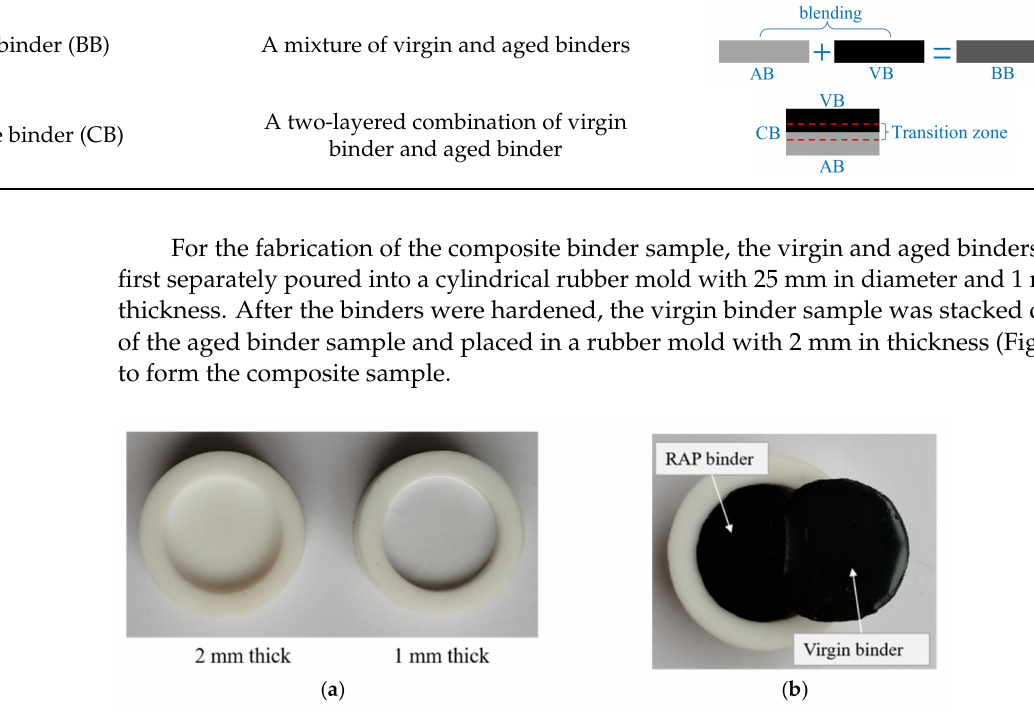
Figure 3. Preparation of virgin-aged composite sample. ( a ) rubber molds; ( b ) composite